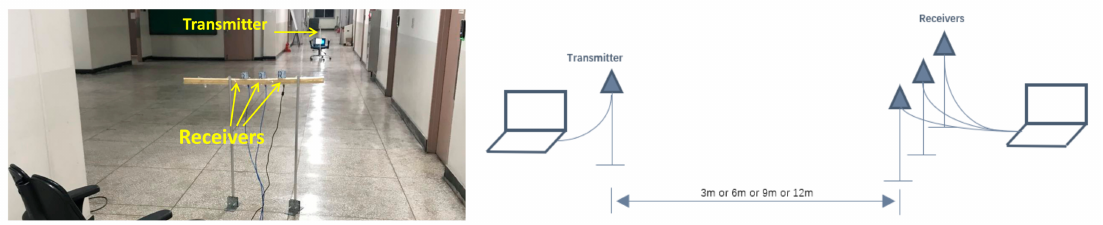
Figure 1. Environment and sketch of RFT detection